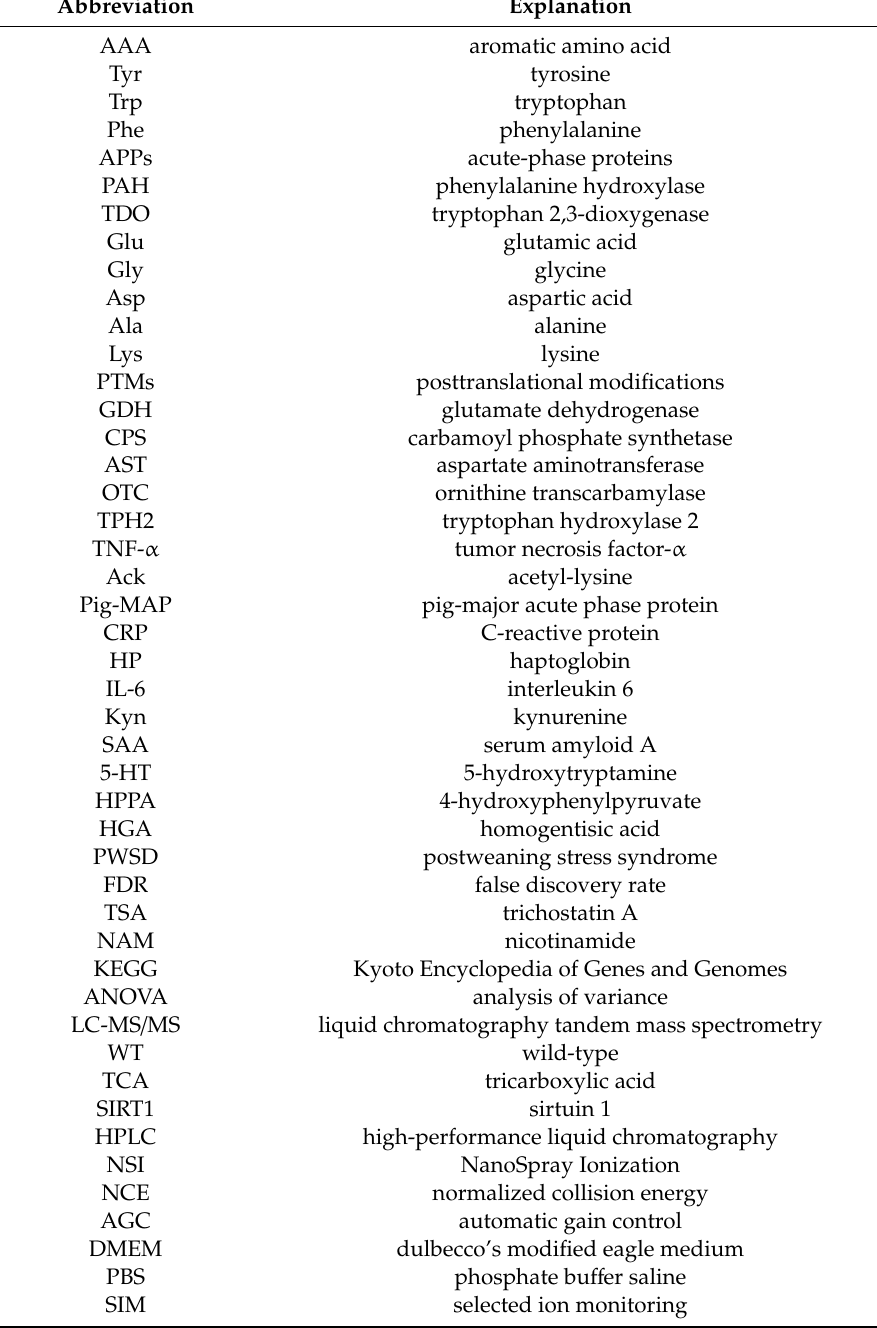
Table A1. Abbreviations of metabolites and their explanation used in this